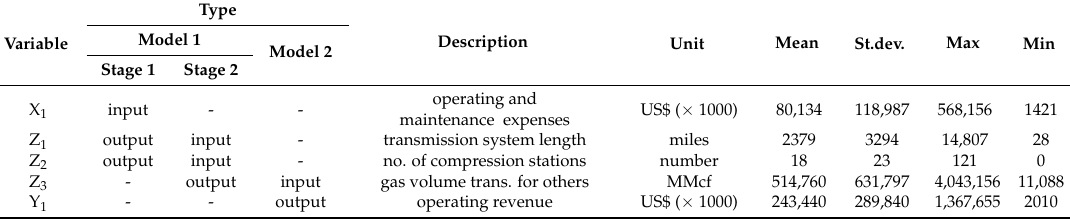
Table 1. Inputs, outputs and intermediate (input/output)